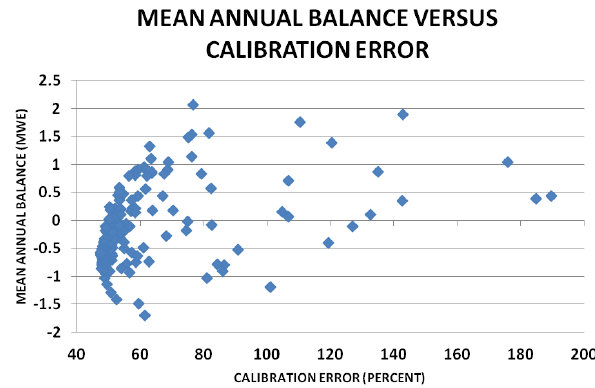
Fig. 4. Mean annual balance versus calibration error. When the cal- Figure 4. Mean annual balance versus calibration error. When the 224 ibration error reached the minimum of about 45%, the average an- calibration error reached the minimum of about 45%, the average 225 nual balance is − 0.6mw.e. Each point represents the mean annual annual balance is -0.6 mwe. Each point represents the mean annual 226 balance based on one year of daily balance determinations. balance based on one year of daily balance determinations. 227 228